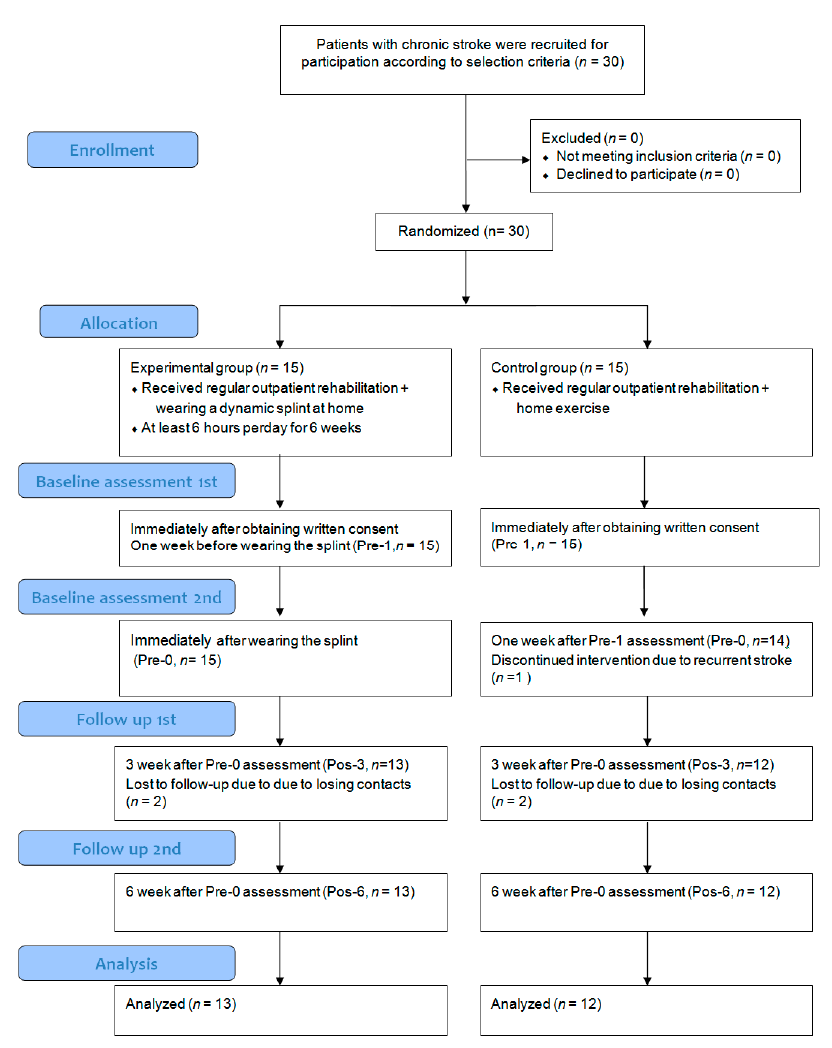
Figure 1. Experiment flowchart.